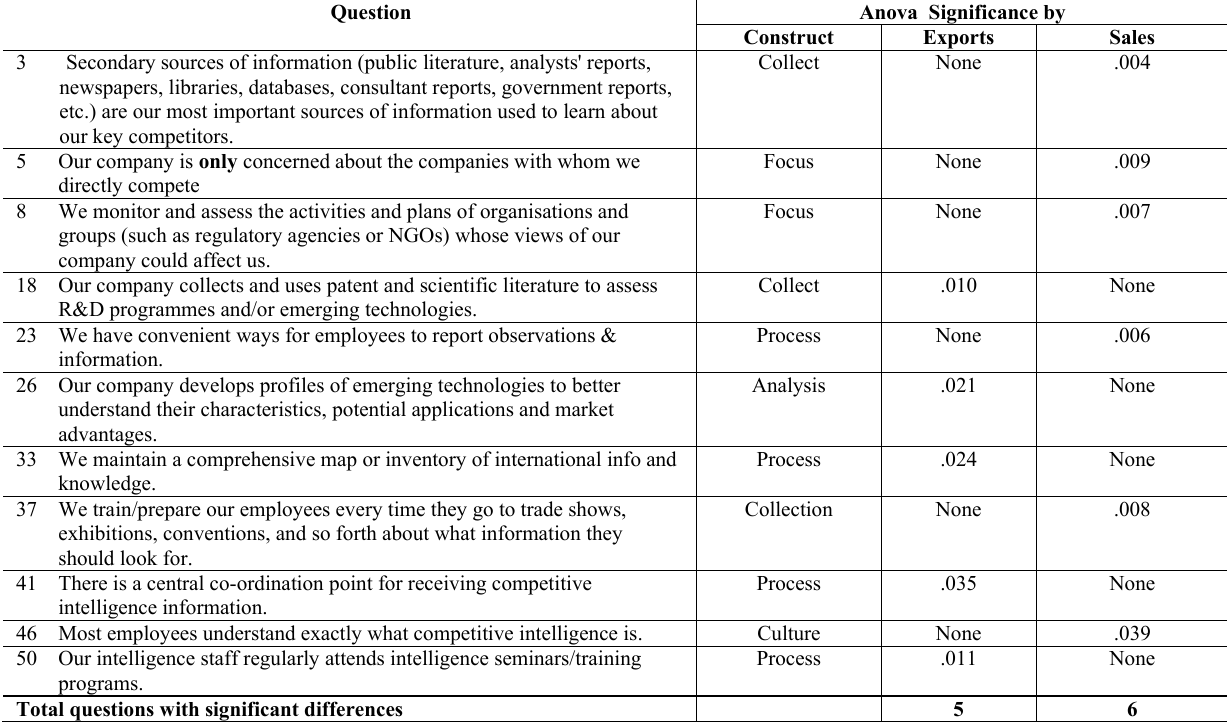
Table 15: Non-response analysis: Results of Anova by exports and employees only for results with significance greater than